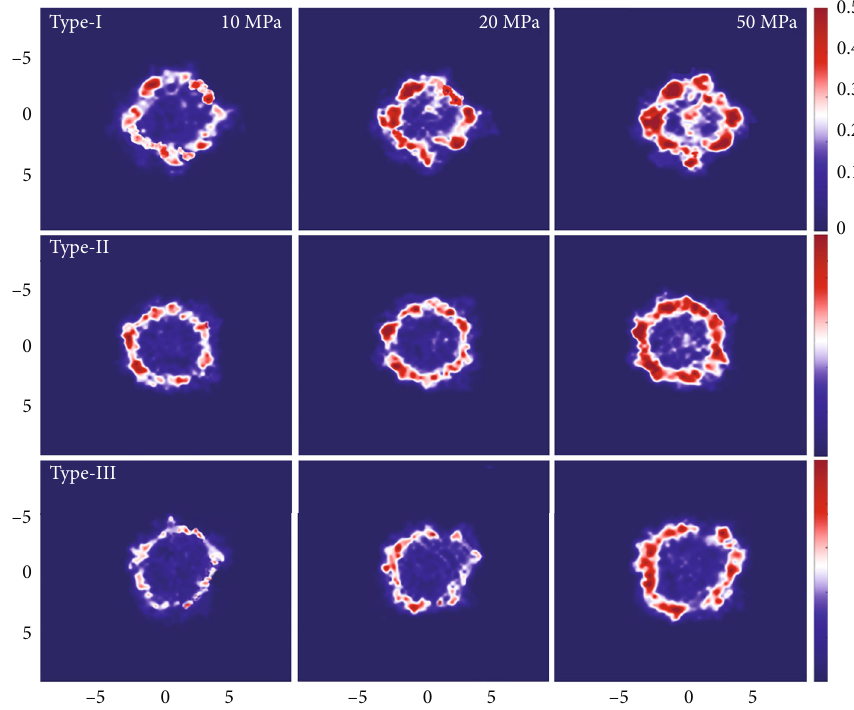
Figure 3: CH density distribution in 1nm shale organic nanopore under di ff erent pressure conditions. 4